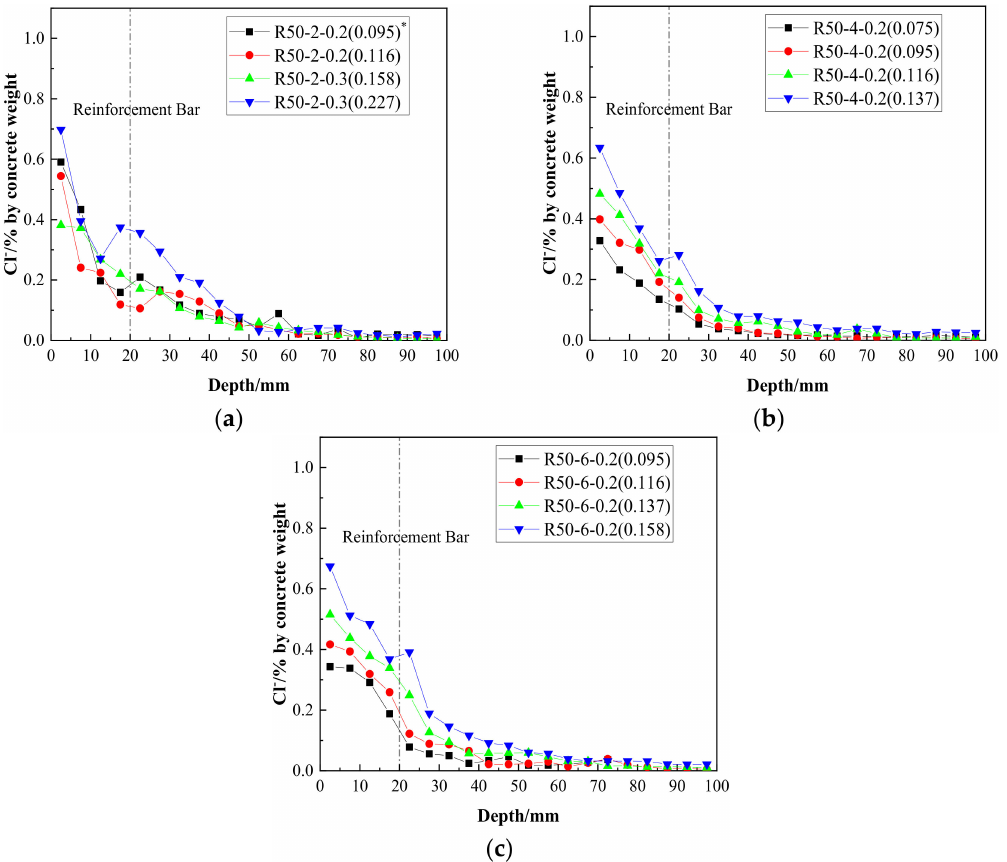
Figure 12. Distribution of chloride ion contents at different depths as a function of crack width when f * 2 = 0.2% ( a ), f = 0.4% ( b ) and f = 0.6% ( c ) (the mass percentage of nano-silica in the cementitious material). Note (*): the values in brackets refer to the actual width of the cracks selected in the specified